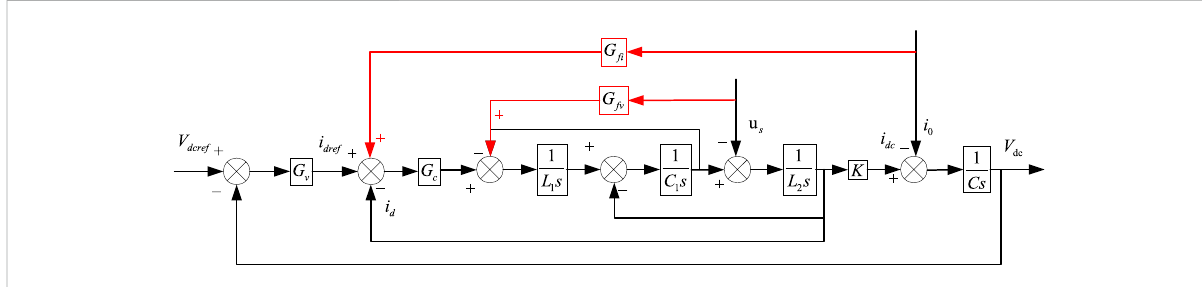
FIGURE 5 Block diagram of double closed-loop control with the addition of feed-forward control.